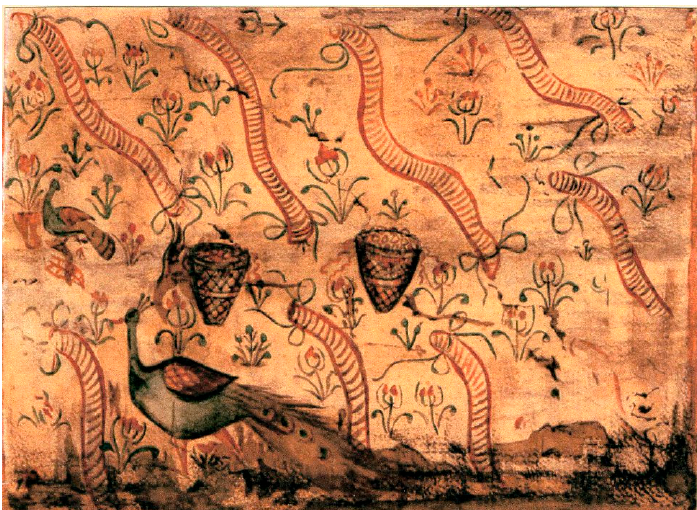
Figure 21. Sardis, Kâgirlik Tepe Tomb (Appendix A.7), painting of south wall. © Archaeological Exploration of Sardis/President and fellows of Harvard College.